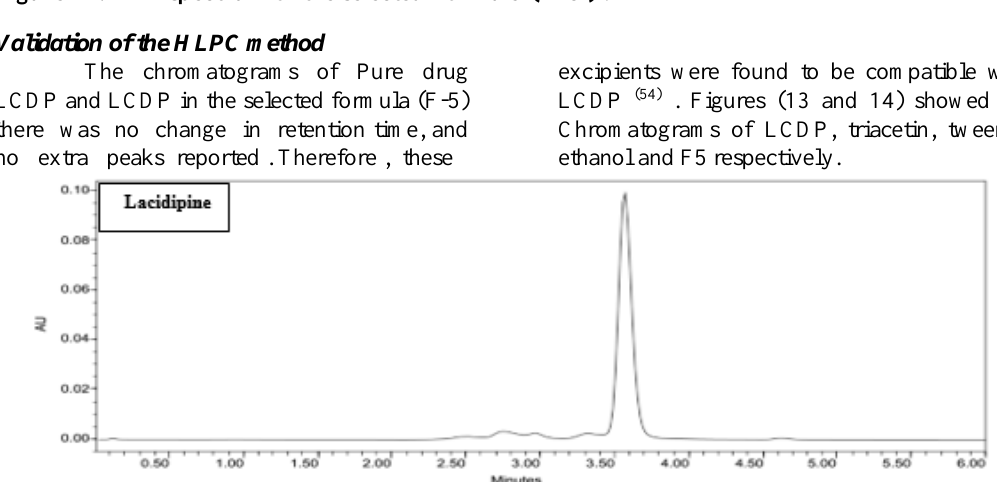
Figure 12.FTIR spectrum of the selected formula ( F-5 ) .